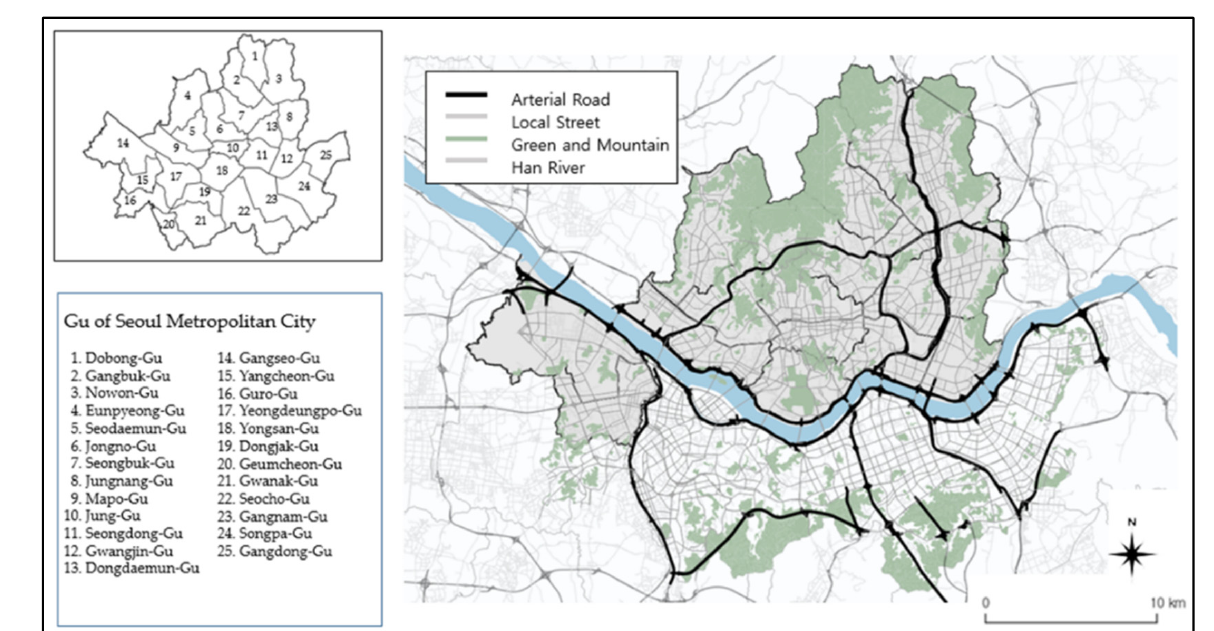
Figure 2. Seoul’s autonomous districts and transportation networks.